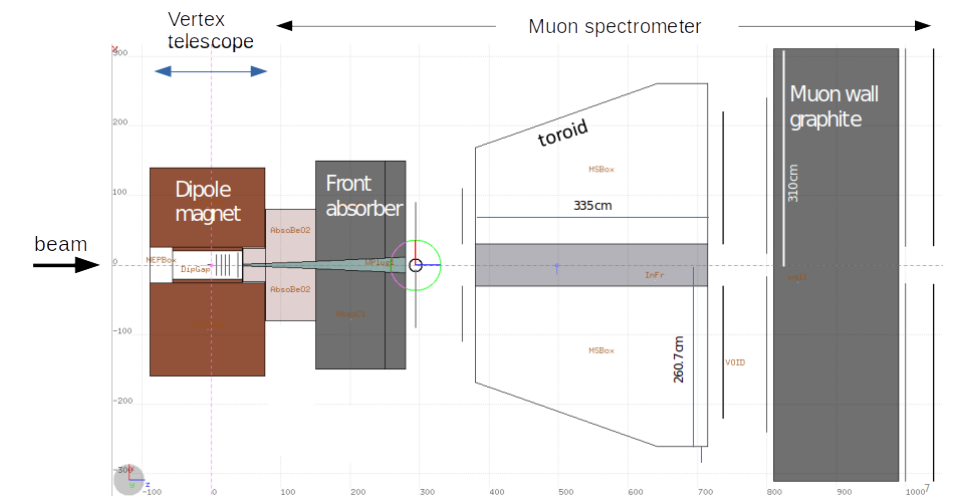
Figure 2. Layout of the proposed NA60 + apparatus in the low energy